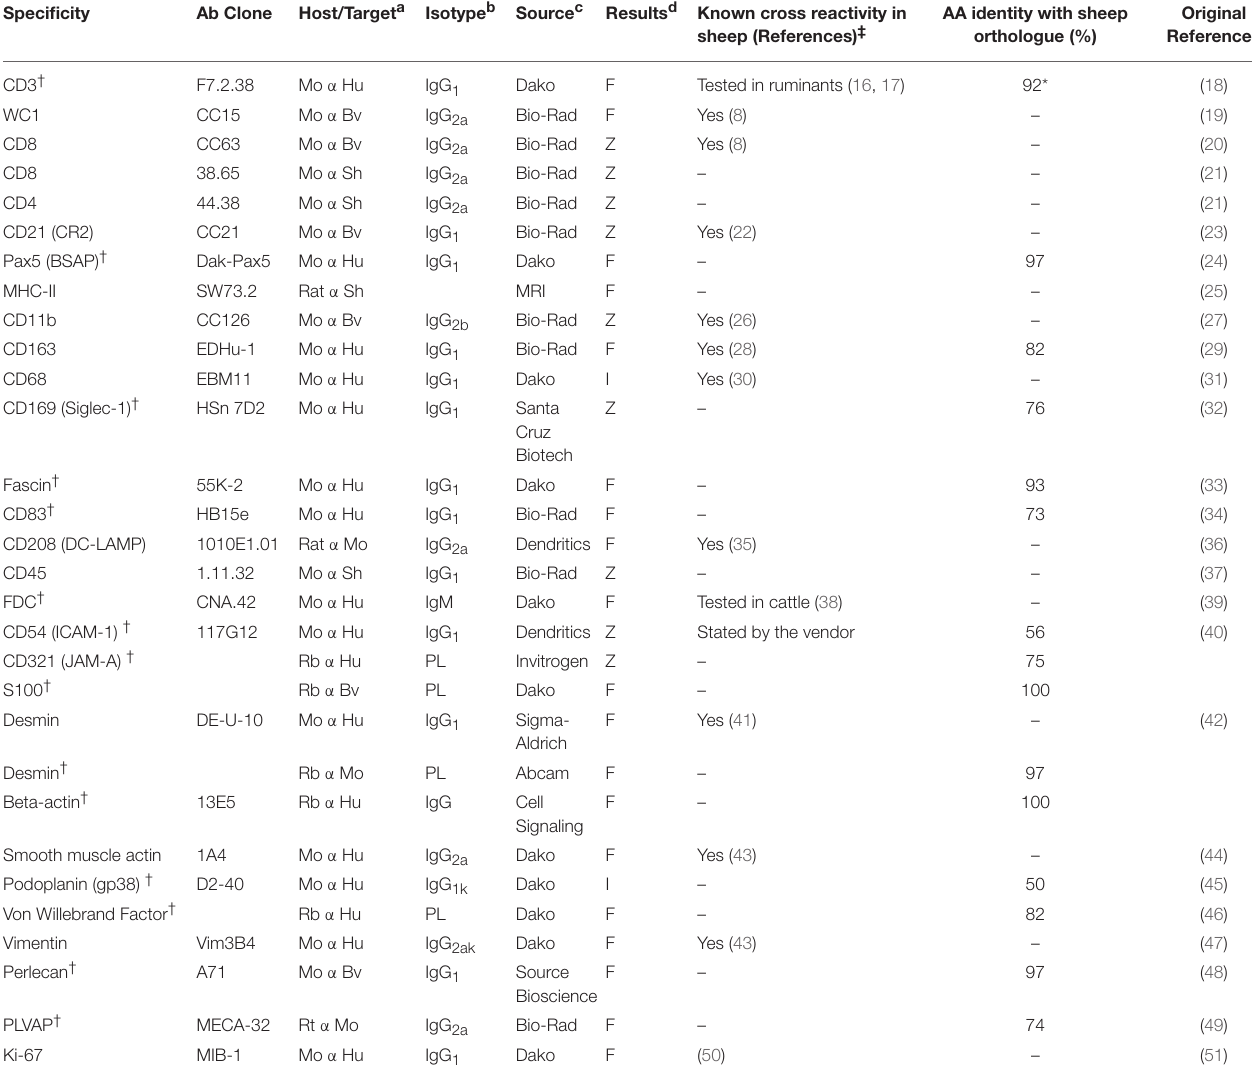
TABLE 1 | List of antibodies successfully used in this study.